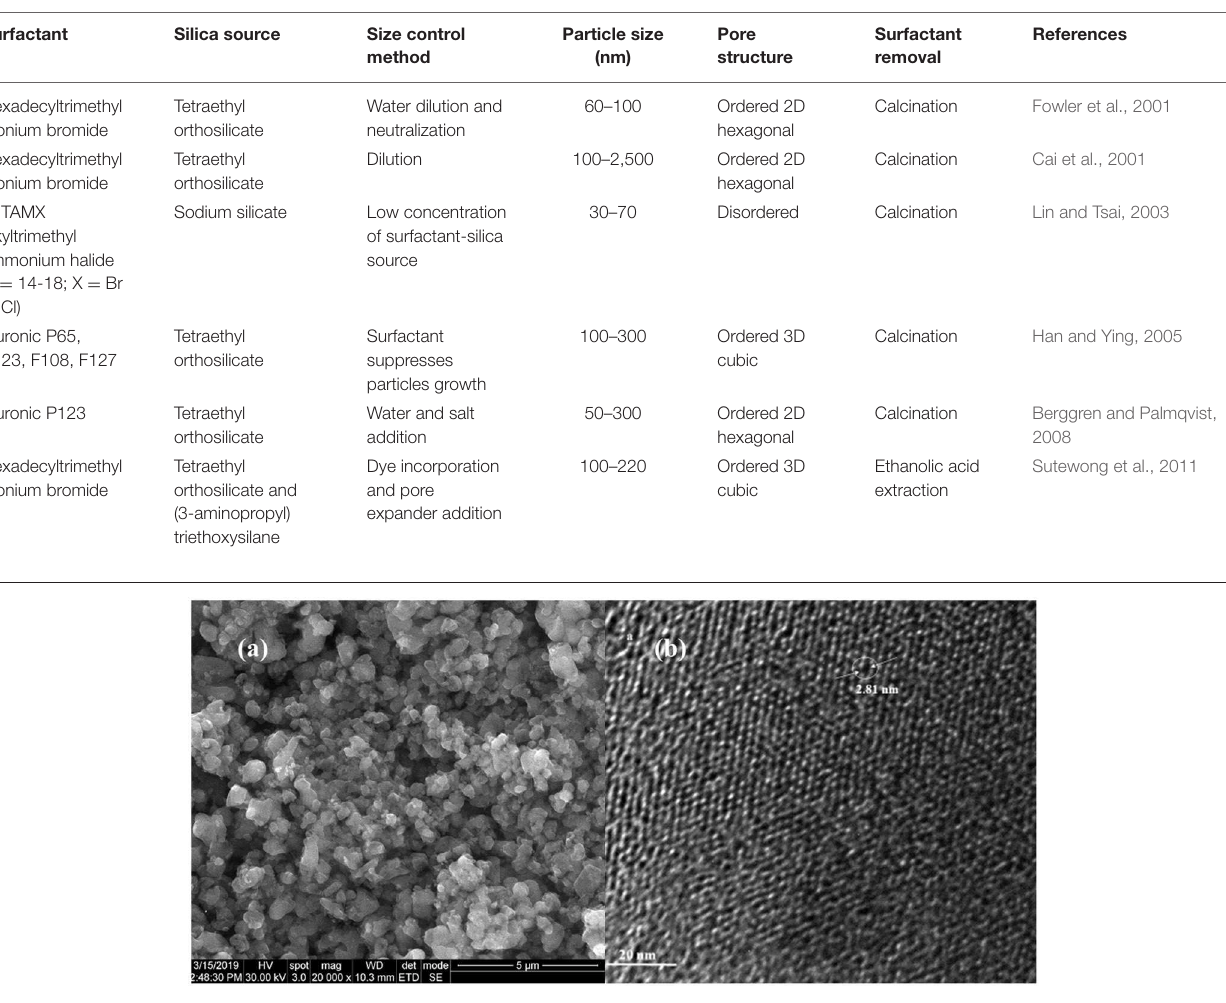
FIGURE 3 | Typical scanning electron (a) and transmission electron (b) microscopy for MCM-41 mesoporous